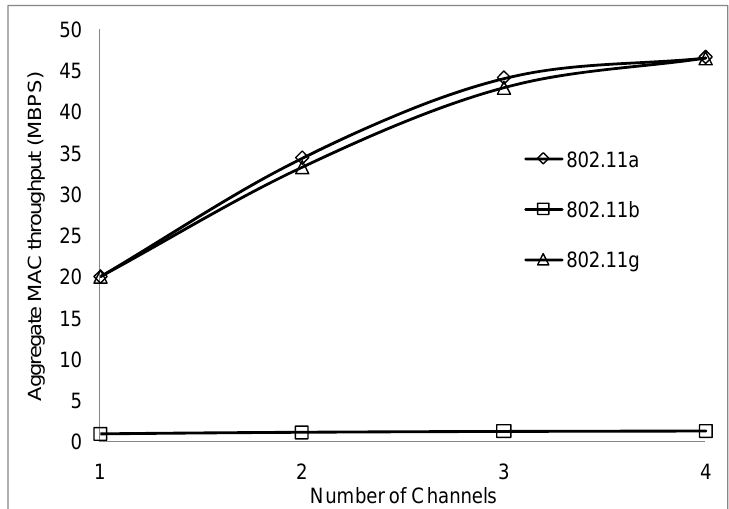
Figure 28. Aggregate throughput at 50 m range and data rate of 54